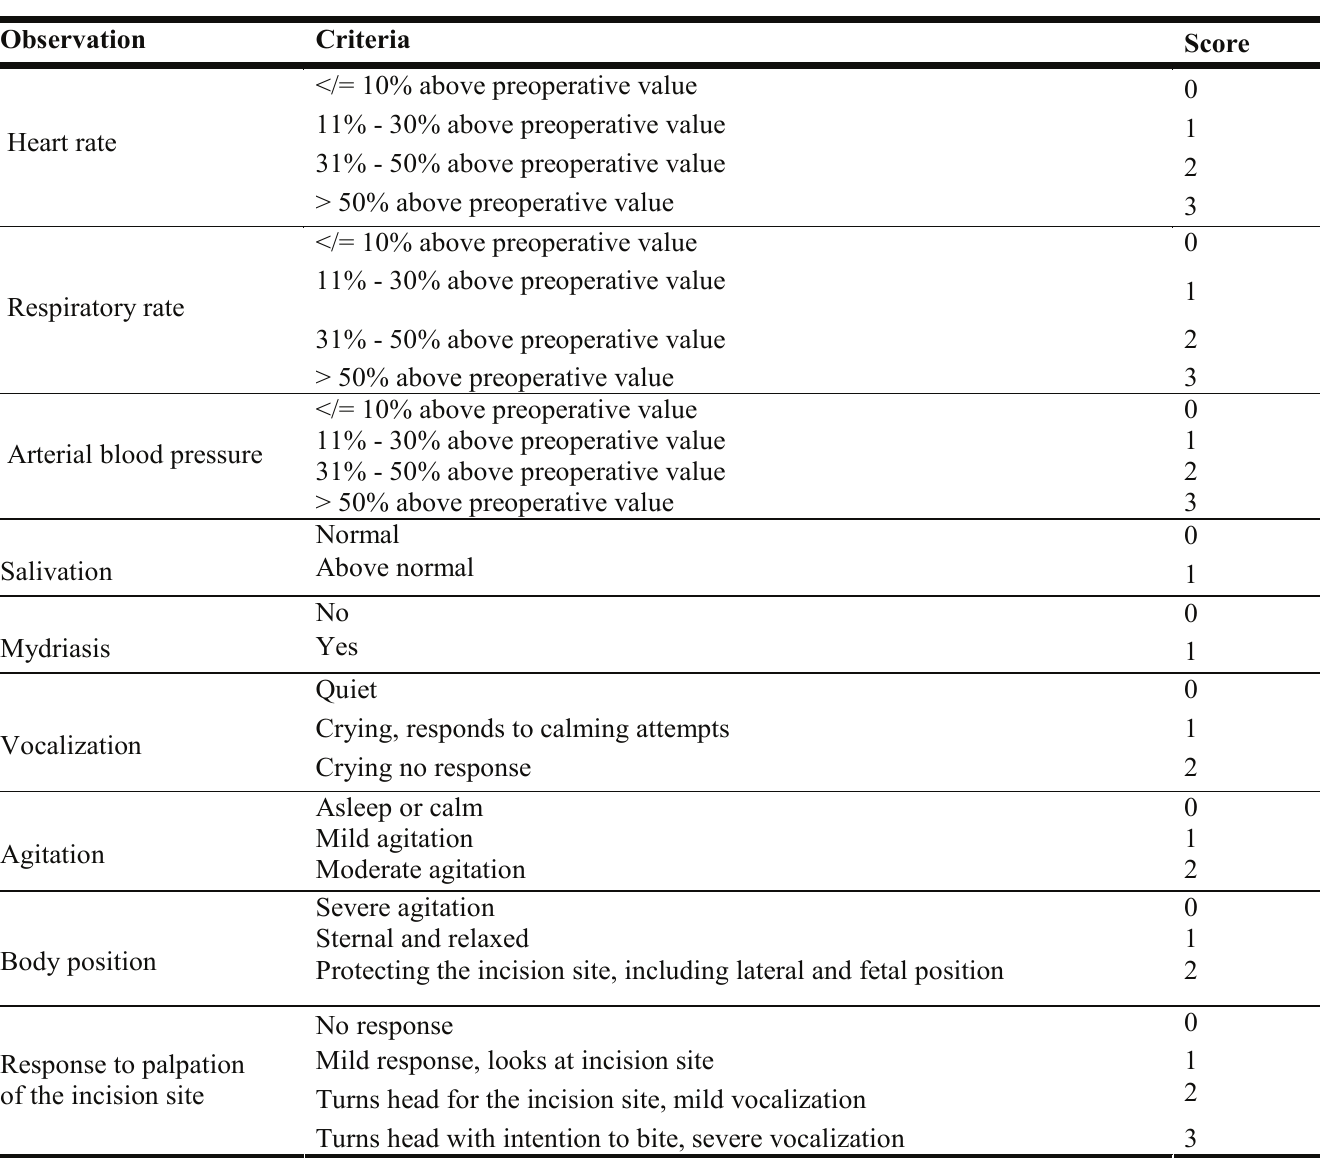
TABLE 1 - Criteria used for scoring postoperative pain in